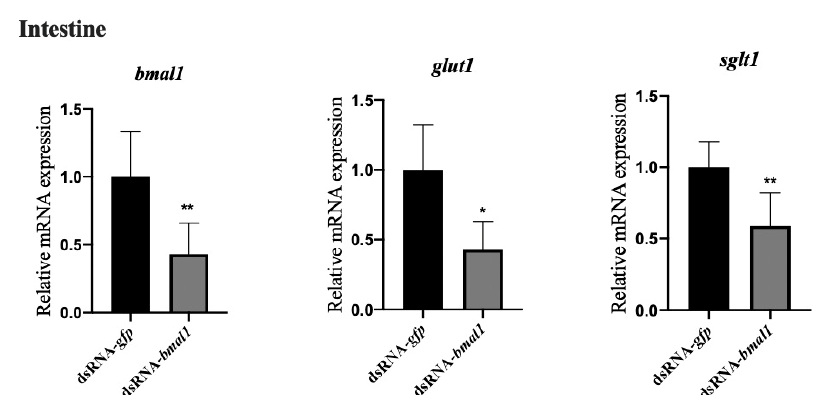
Figure 4. The knockdown of BMAL1 decreased the mRNA expression of glucose transporters (GLUT1, SGLT1) in the hepatopancreas and intestine of L. vannamei. Each bar represents the mean ± SD of six samples. Bars assigned with asterisk are significantly different. * indicates p < 0.05, ** indicates p < 0.01, indicates *** p < 0.001).